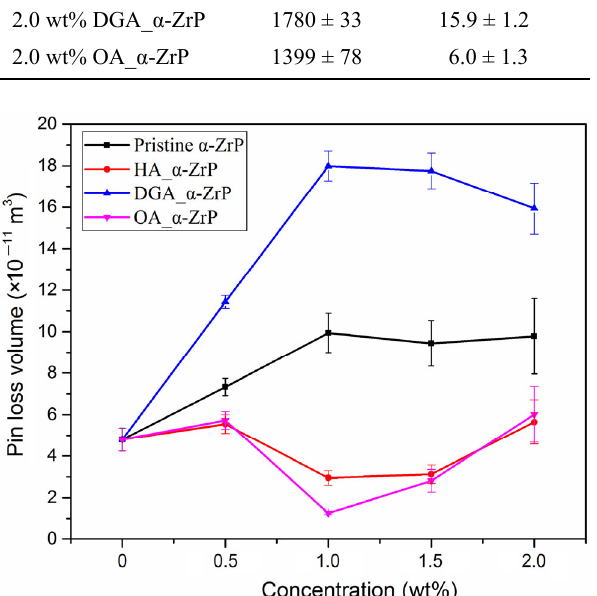
Fig. 9 Pin volume loss as a function of concentration for pristine  -ZrP, HA_  -ZrP, DGA_  -ZrP, and OA_  -ZrP nanosheets in mineral